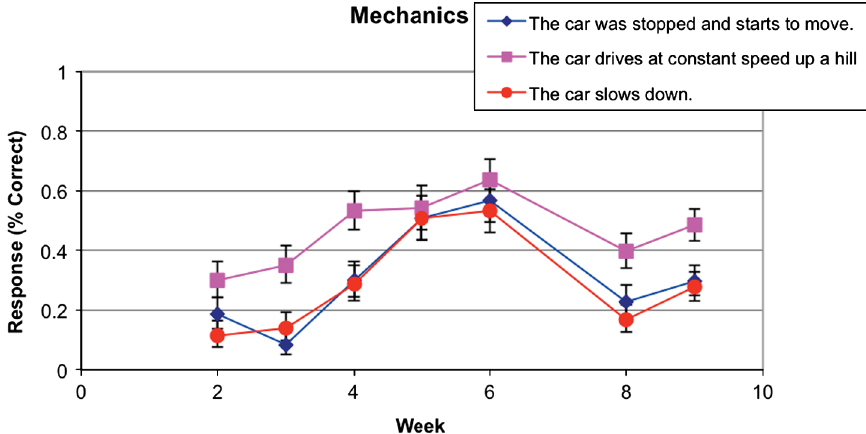
FIG. 5 (color online). Response curve for Mechanics. Before instruction response could be chance. There is a broad peak during instruction with a maximum during week 6 which is the end of the section on forces.